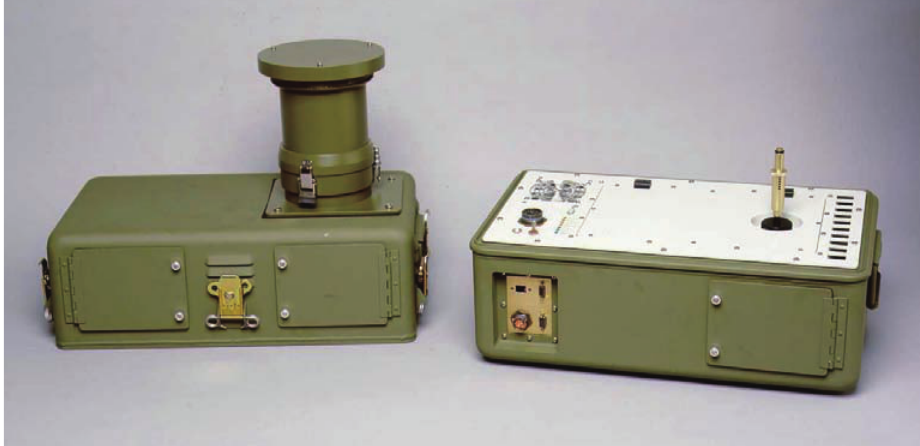
Fig. 6 Prototype FLAPS3 showing a virtual impactor on the left and the particle detection electronics on the right. The coupling of the two systems was accomplished via a spring loaded aerosol transfer tube shown as a golden exten- sion on the right unit. Combining the two units with four clasps resulted in a single one person portable instru- ment that was designed to be weather proof. In practice, it performed well during a tropical storm. Consequently, it was possible to sample biological aerosol content during rainy periods. This capability opened up a hitherto unprecedented opportunity to explore the presence of biological aerosol content associated with rain